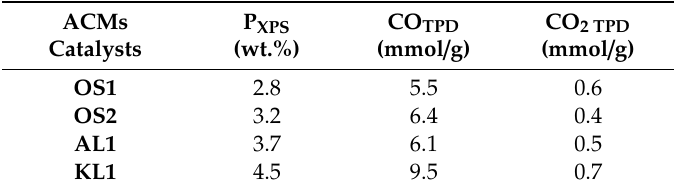
Table 1. Mass surface concentration of phosphorus determined by X-ray photoelectron spectroscopy (XPS) analyses and CO and CO 2 evolved quantities from temperature-programmed desorption (TPD)